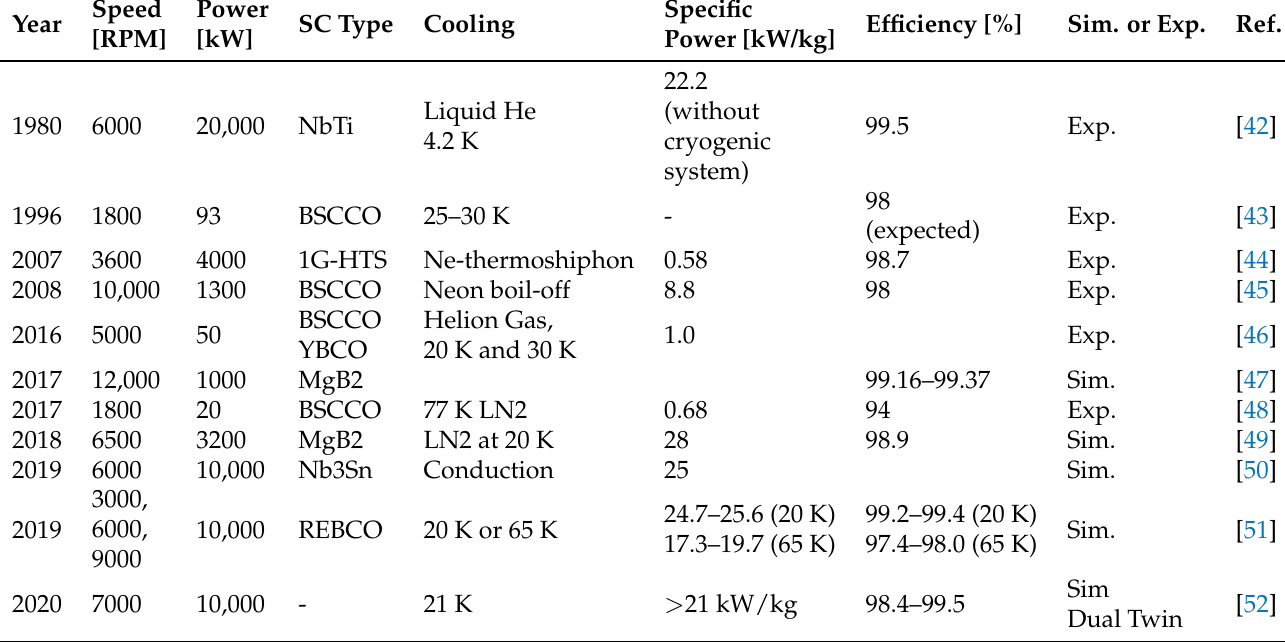
Table 1. Survey of superconducting machine designs with efficiency and specific power